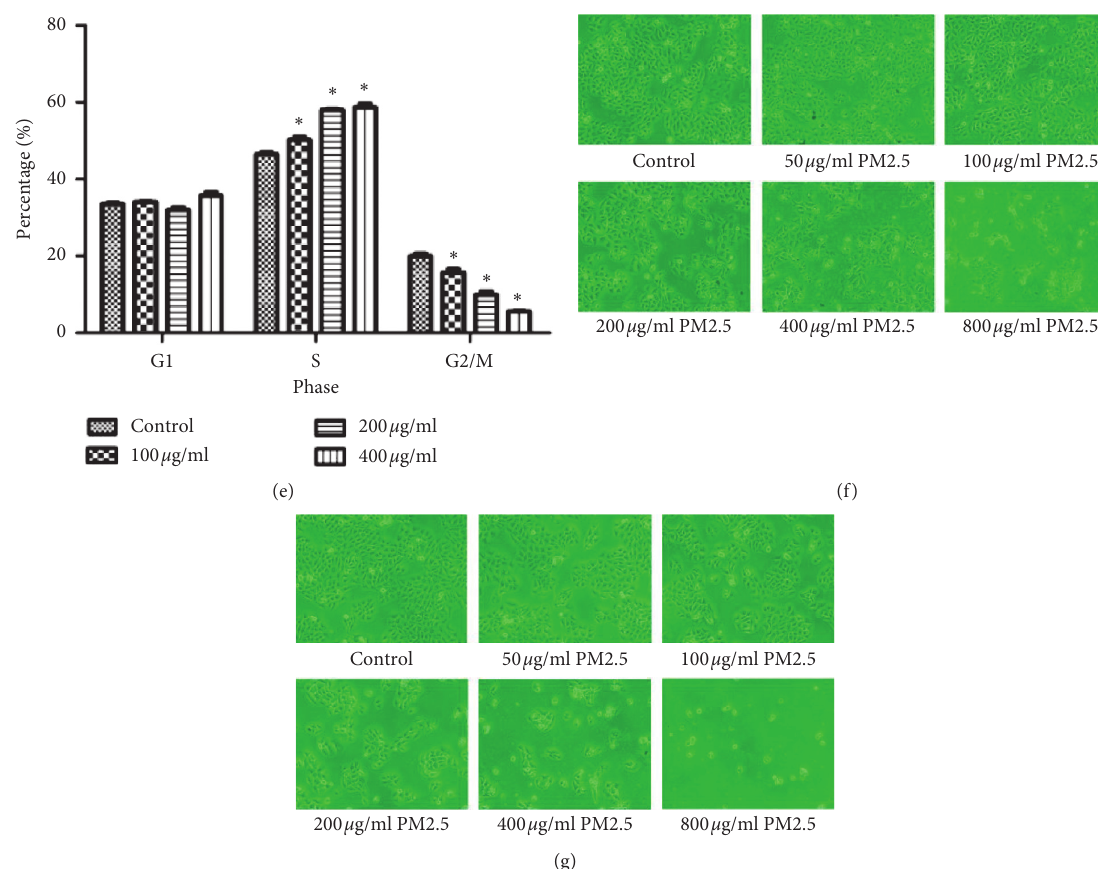
Figure 1: (a) Stimulated with different concentrations of PM2.5 (50ug/ml, 100ug/ml, 200ug/ml, and 400ug/ml) in HaCaTcells at 24h and 48h, the cell activity decreased with the increase in PM2.5 concentration. (b–e) Stimulated with different concentrations of PM2.5 (50ug/ml, 100ug/ml, 200ug/ml, and 400ug/ml) in HaCaT cells at 24h and 48h, the cell cycle was significantly inhibited with the increase in PM2.5 concentration. (f, g) HaCaT cells after 24h and 48 h PM2.5 treatment observed under microscope. ∗ P < 0 .